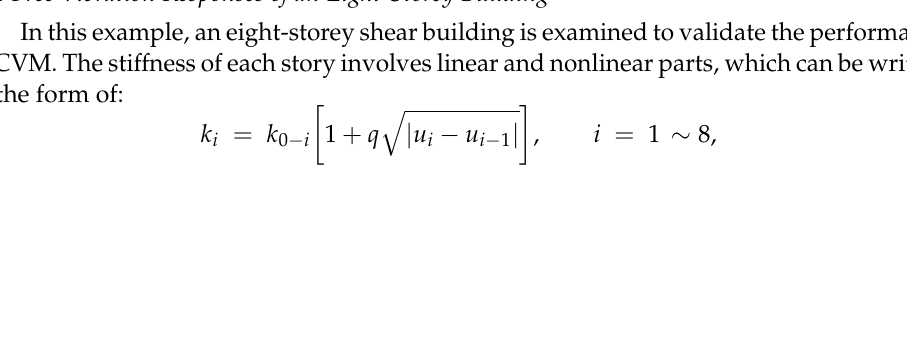
Figure 11. Displacement responses to CHY028 and the corresponding hysteretic loops for ρ = 0.5 .